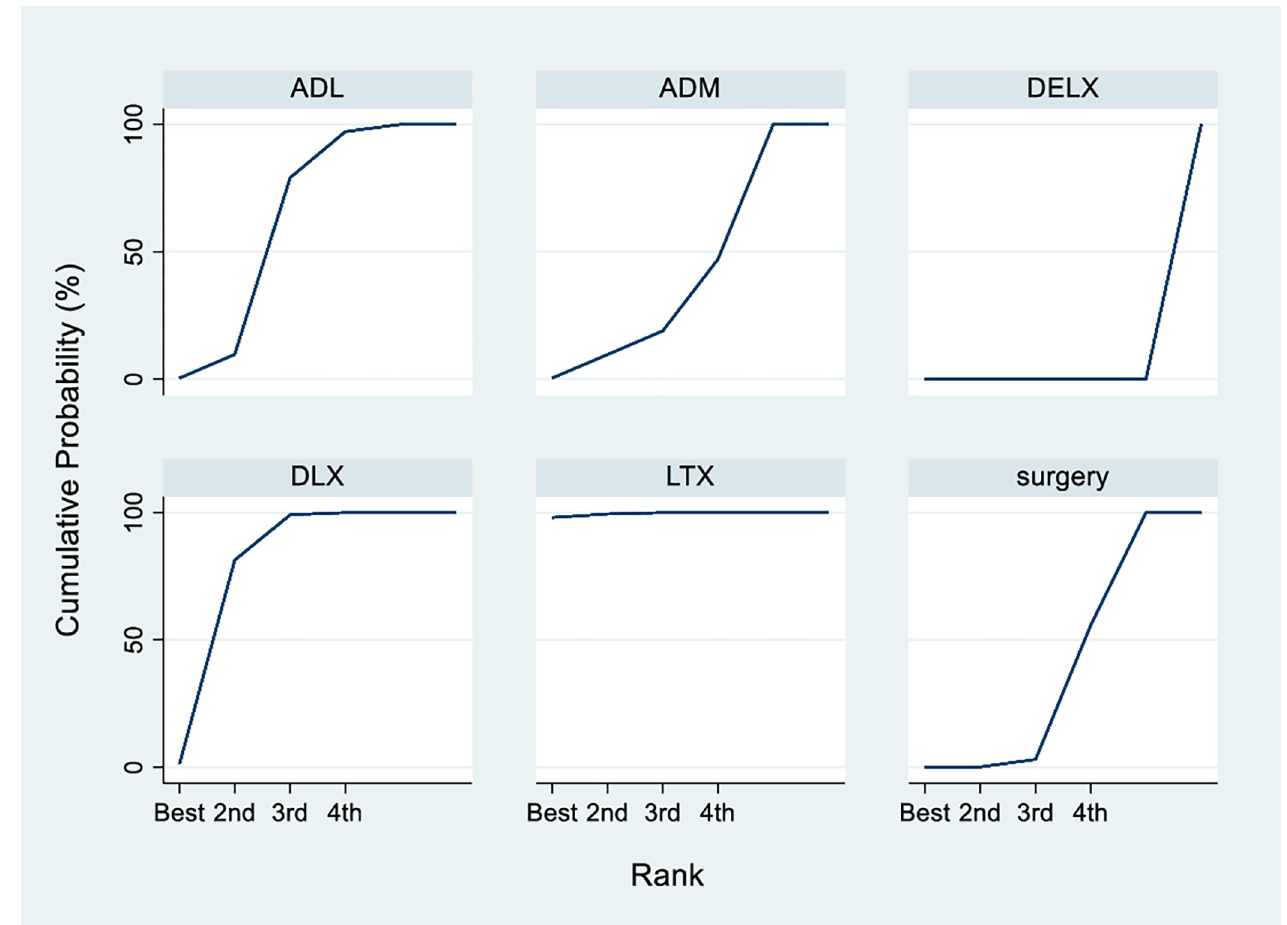
Fig 5. Plot showing the assessment of